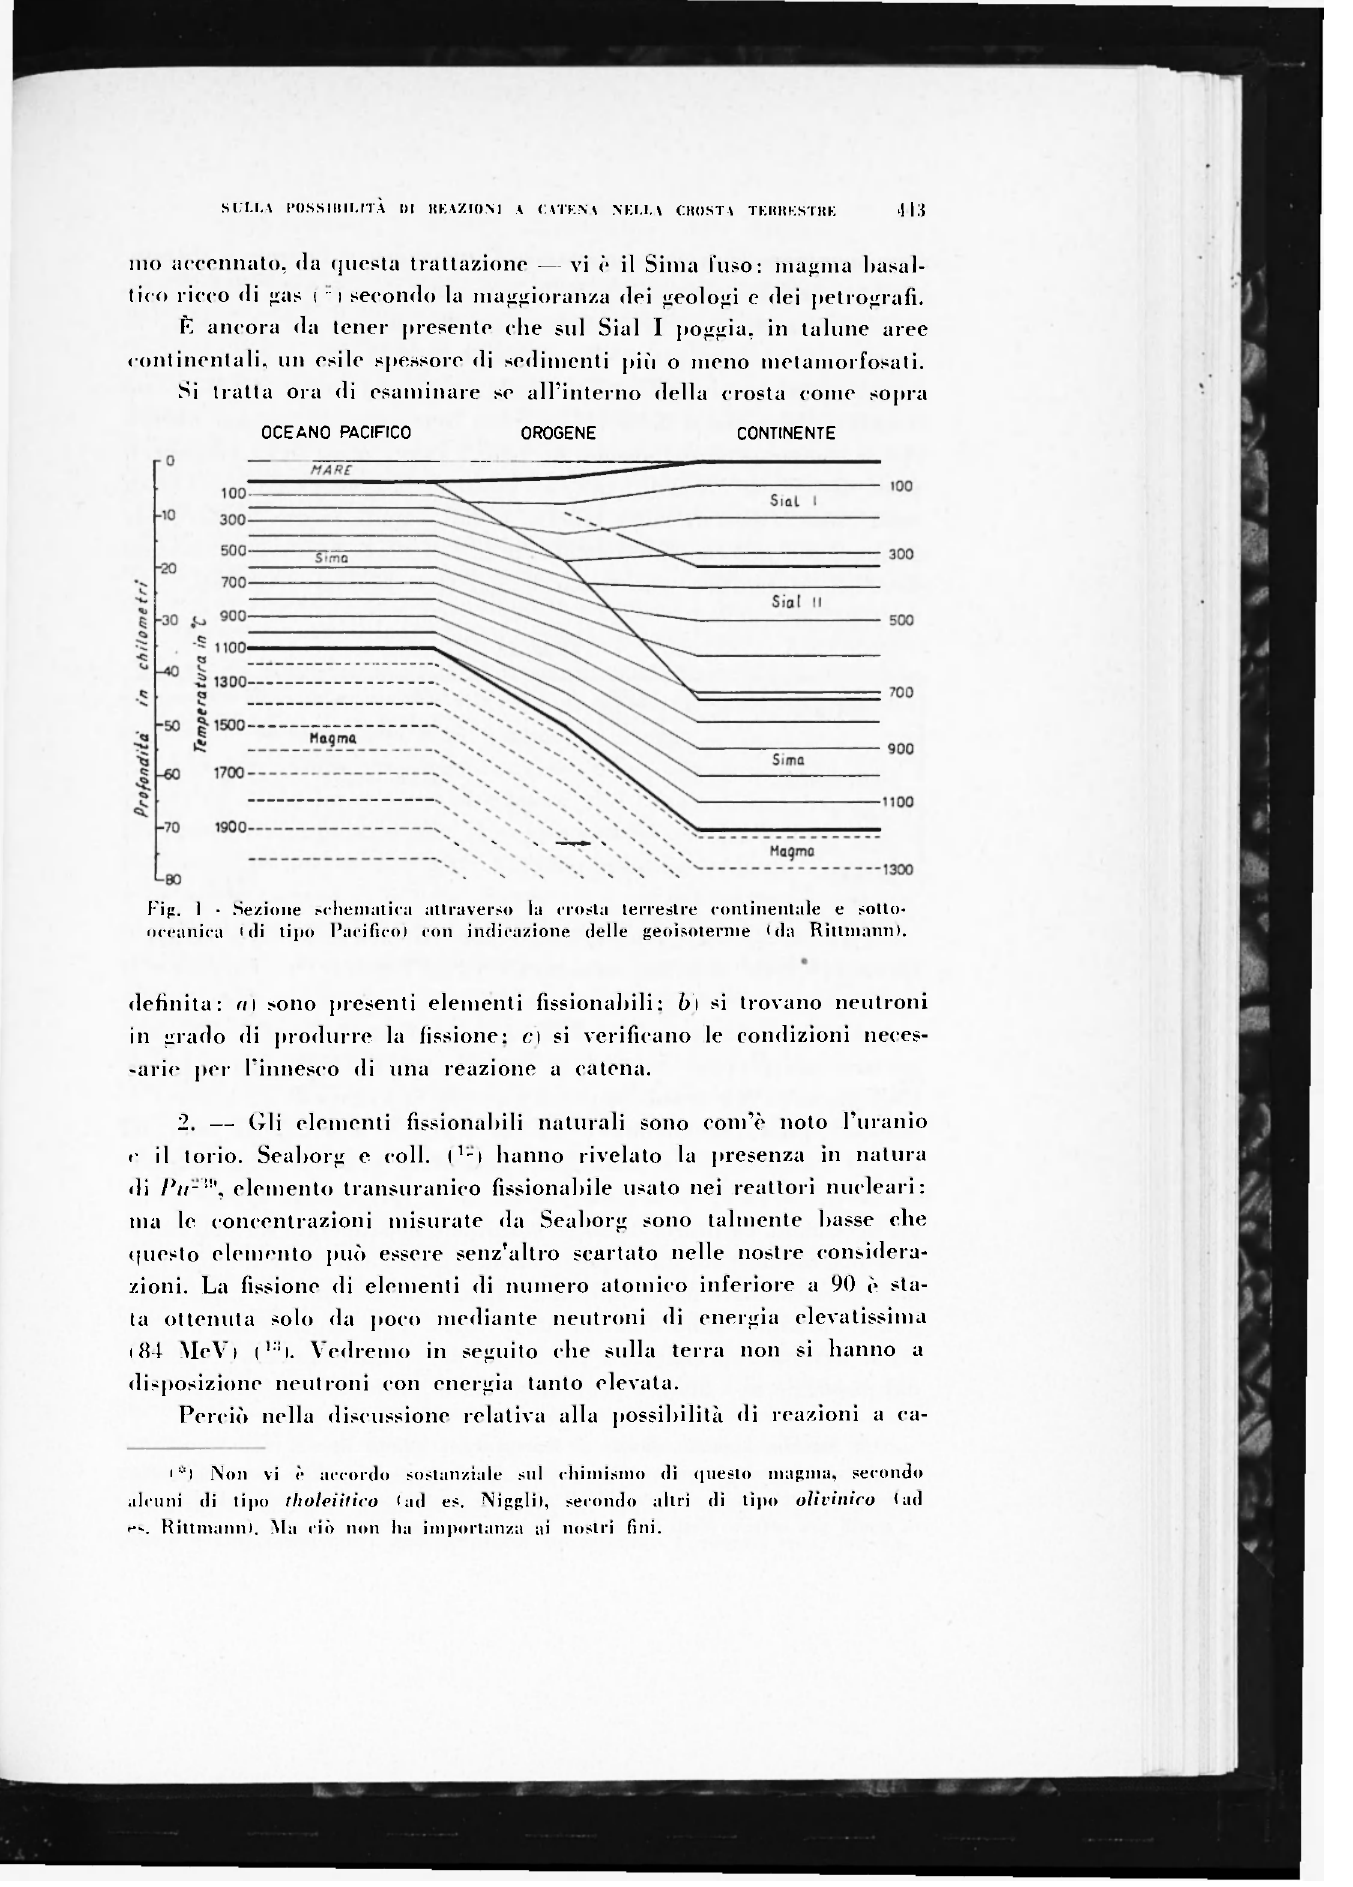
definita: n l sono presenti elementi